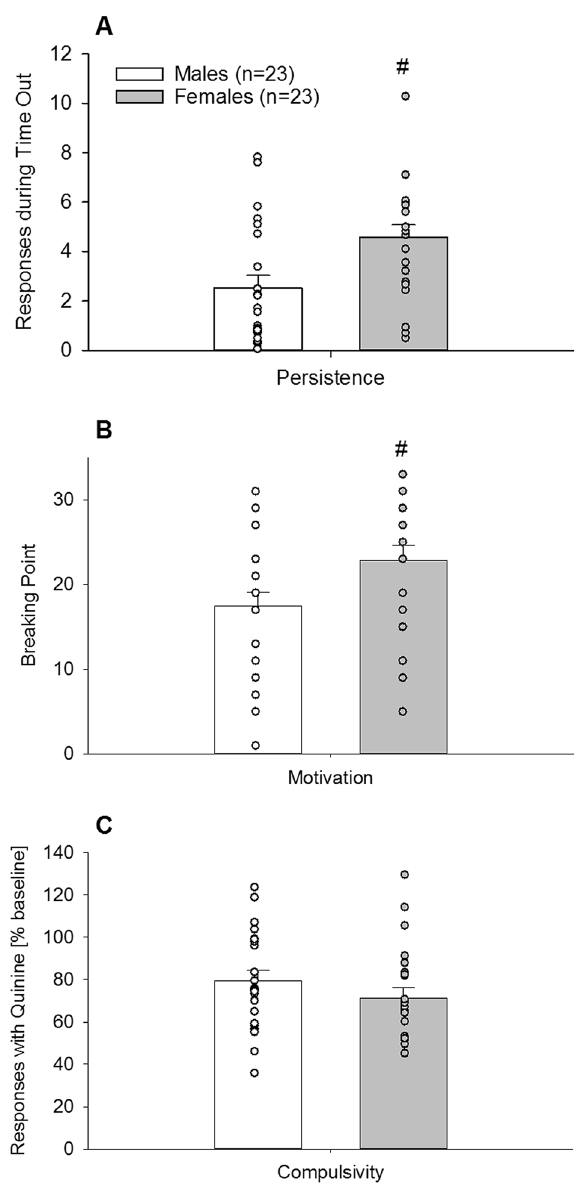
Figure 7. Addictive-like phenotypes of persistence, motivation and compulsivity in long-term operant sugar self-administering male (n = 23) and female (n = 23) mice (Experiment 3b). ( A ) Persistence was measure by the TO test. During the single 6 min time out of sugar access, the number of lever presses per min was almost doubled in females (grey bar) compared to male (white bar). ( B ) Motivation as assessed by a PR schedule of reinforcement. The breakpoint or limit to the amount lever pressing that male mice were willing to perform to obtain sugar was around 17, while in females it was significantly increased to almost 23. ( C ) Compulsive-like behavior by taste adulteration with quinine reduced the number of lever presses to obtain sugar similarly in both male and female mice. All data represent mean + SEM. (#) and (##) indicate P < 0.05 and P < 0.01 versus male mice,